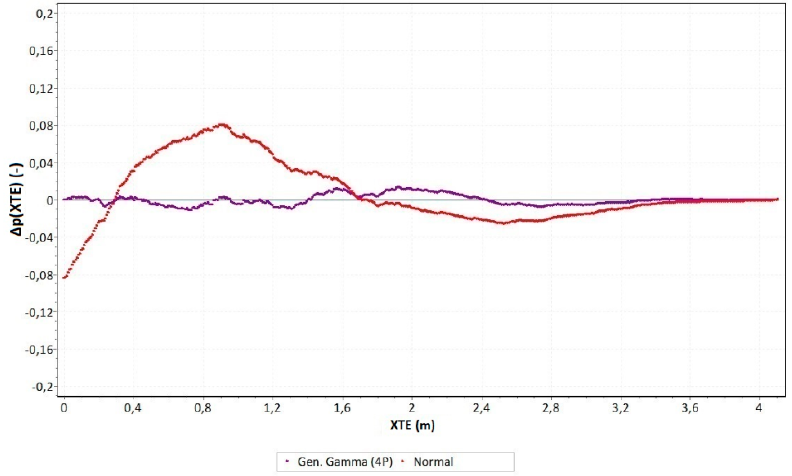
Figure 11. The di ff erence between the probabilities of the occurrence of variable XTE for the empirical Figure 11. The difference between the probabilities of the occurrence of variable XTE for the and theoretical generalised gamma empirical and theoretical generalised gamma distribution.